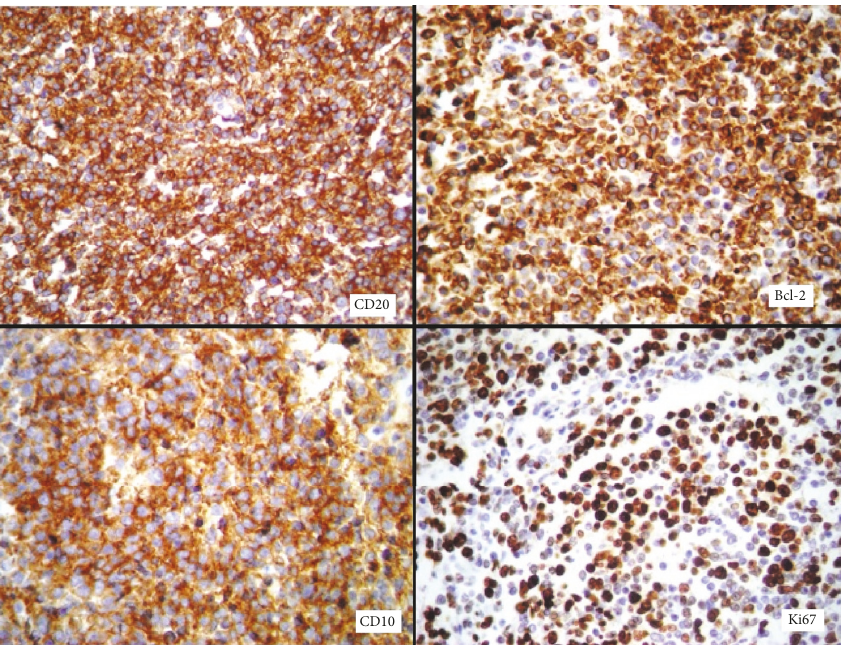
Figure 1: Immunohistochemistry showing positivity of the antibodies CD20, Bcl-2, and CD10 in atypical lymphocytes and Ki67 in 50% of all lymphocytes.